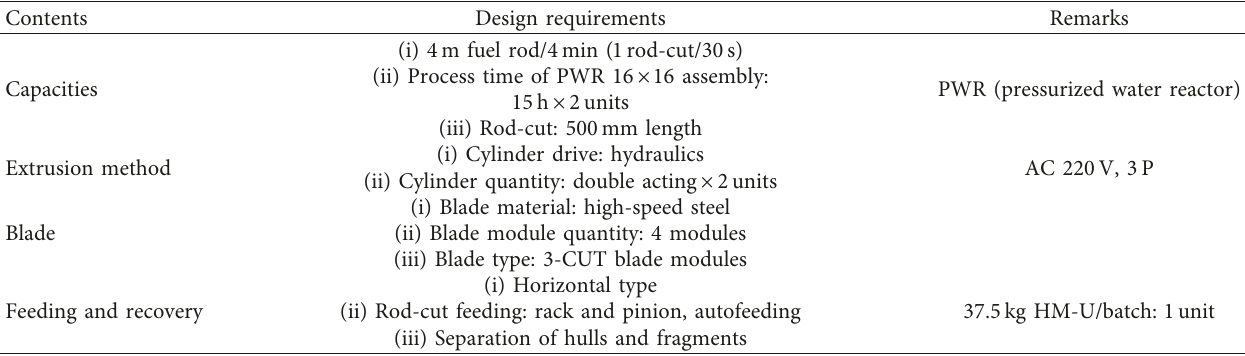
Figure 12: Comparison of electric and hydraulic type for space: (a) space; (b) length. Table 3: Design requirements of mechanical decladder.